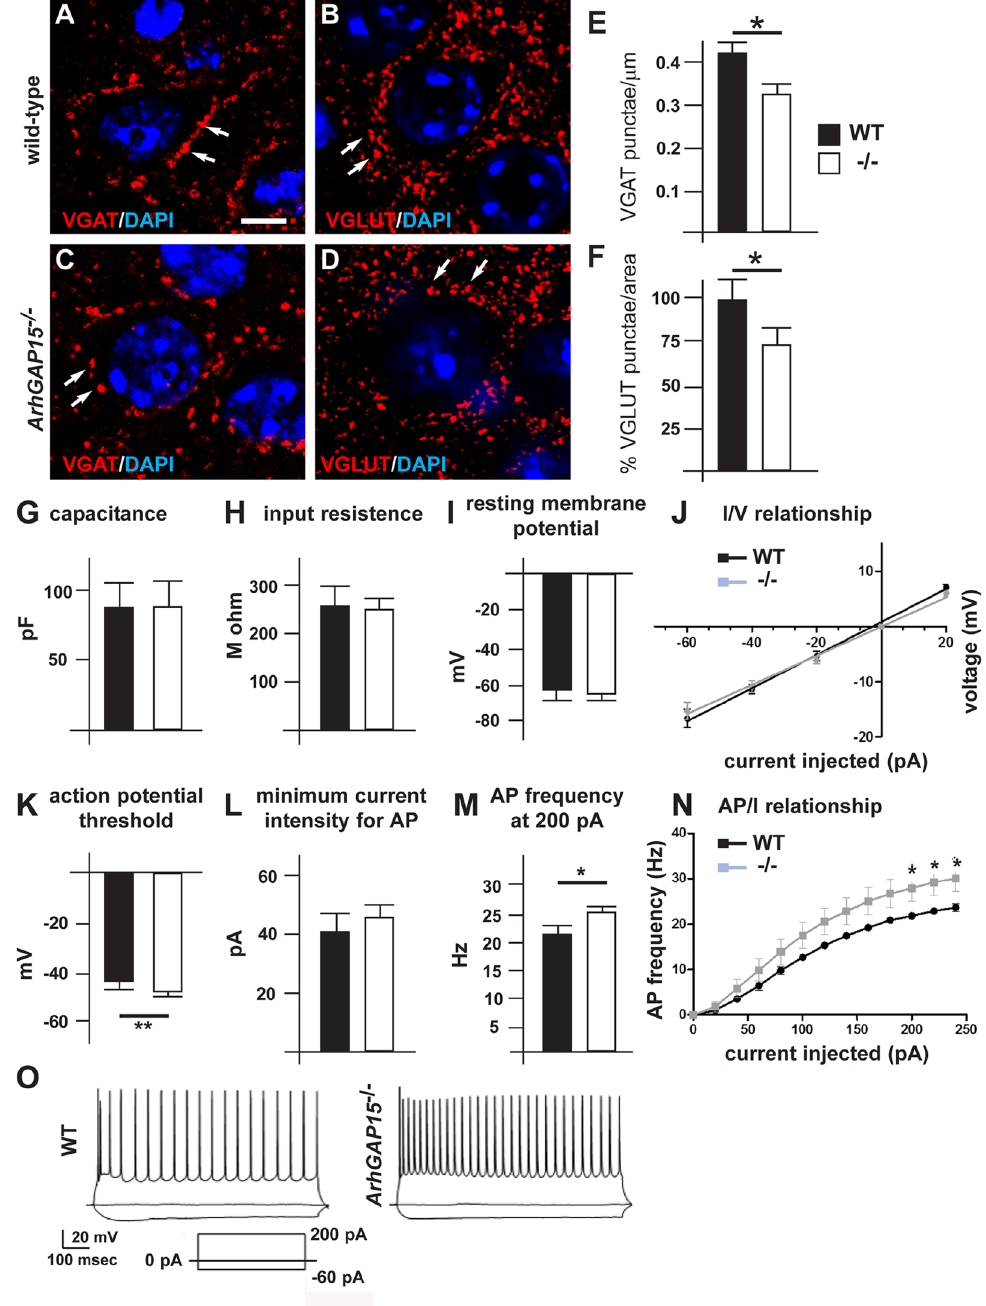
Figure 6. Synapses and electrophysiology of pyramidal neurons in ArhGAP15 − / − mice. ( A – D ) Representative images of excitatory and inhibitory synapses on the soma of pyramidal neurons in the somatosensory cortex of WT ( A , B ) and ArhGAP15 − / − ( C , D ) brains, at P45. Sections were immunostained for VGAT (left panels, red fluorescence) or for VGLUT (right panels, red fluorescence). Nuclei were counterstained with DAPI. Scale bar in A = 2 μ m. ( E , F ) Average number of VGAT + ( E ) and VGLUT ( F ) punctae per surface of neuronal soma. WT, solid bars, ArhGAP15 − / − , open bars. The density of VGAT + punctae is significantly decreased in the mutant cortex. Asterisks indicate statistical significance (p < 0.01). ( G – O ) Electrophysiology of cortical pyramidal neurons. Slices of the somatosensory cortex from WT (open bars) or ArhGAP15 − / − (solid black bars) animals, at P100, were used for recordings. At least 30 neurons were examined per slice. ( G–J ) Passive electrical properties, including the capacitance ( G ), the resistence to input current ( H ), the resting potential ( I ) and the current/voltage ratio ( J ). No differences are observed between the two genotypes. ( K – N ) Active electrical properties including the threshold to action potentials (APs) ( K ), the minimal current intensity to induce APs ( L ), the frequency of APs at various currents (200 pA) is shown in ( M ) and the AP/current ratio ( N ). We observe a significantly reduced threshold to APs and an increase frequency of APs at 200 pA. ( O ) Representative traces of WT (left) and ArhGAP15 − / − (right) neurons. * indicates p < 0.05; *** indicates p <